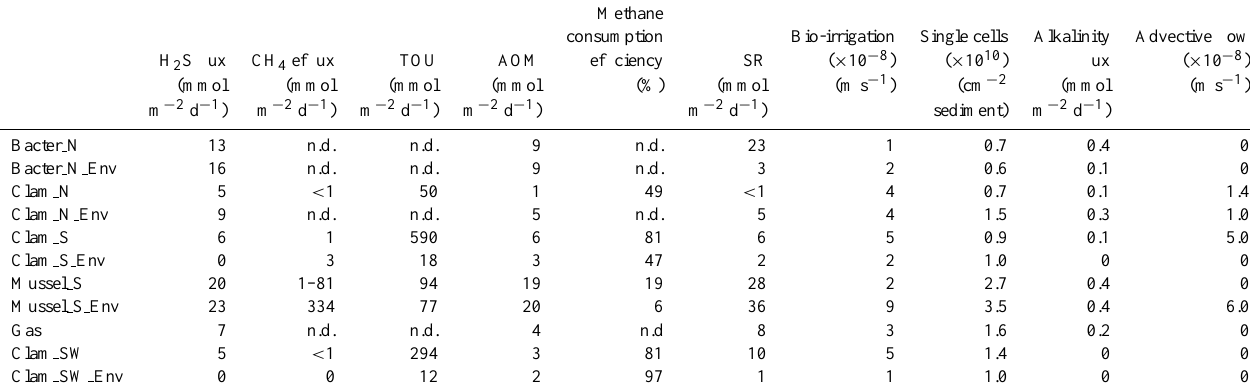
Table 2. Biogeochemical characterization of different habitats at REGAB. Maximum H 2 S flux in the sediment, CH 4 efflux, total oxygen uptake (TOU), average integrated (0–10cm sediment depth) anaerobic oxidation of methane (AOM) and sulphate reduction (SR) rates, methane consumption efficiency calculated as the percentage of methane consumption (AOM) from the total methane flux (AOM+CH 4 efflux), total integrated (0–10cm sediment depth) single cell numbers, as well as alkalinity flux and modelled values of bio-irrigation and advective